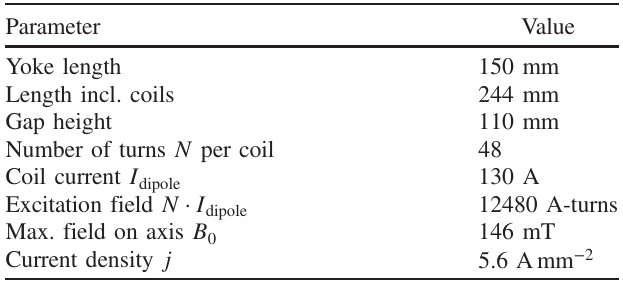
TABLE I. Main parameters of the chopper magnet.